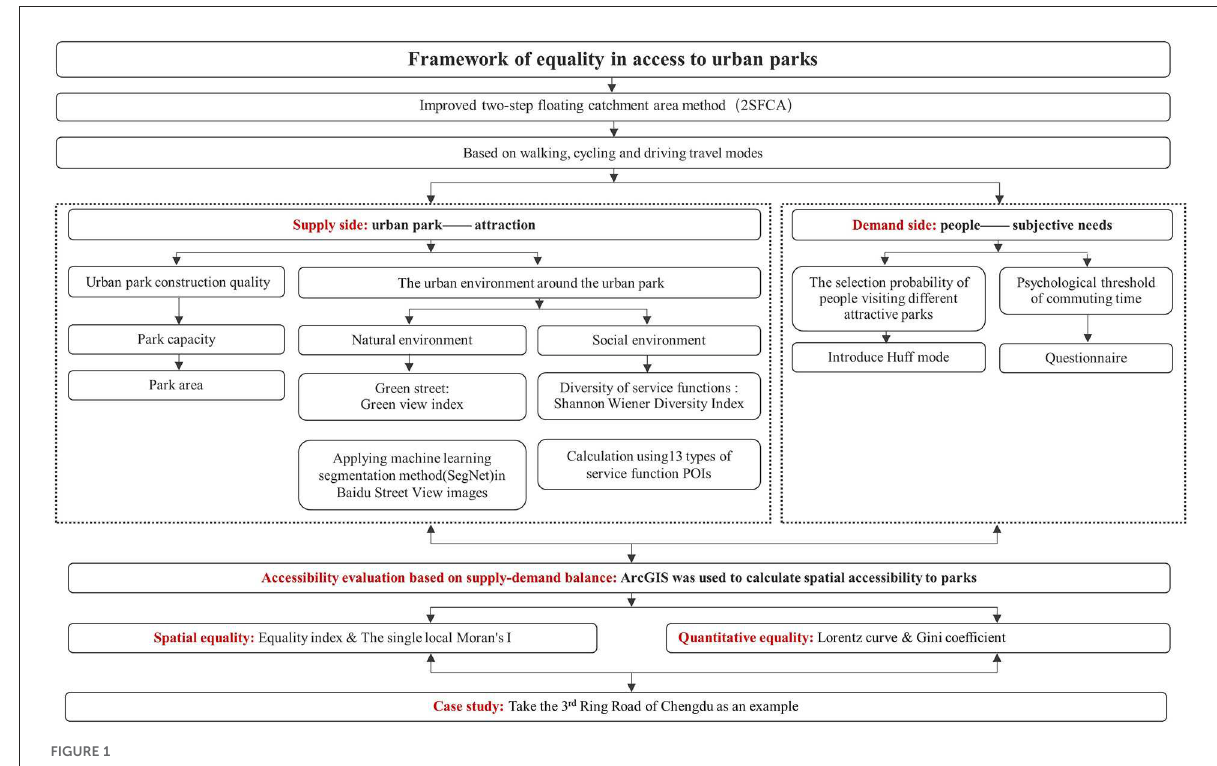
FIGURE1 Research